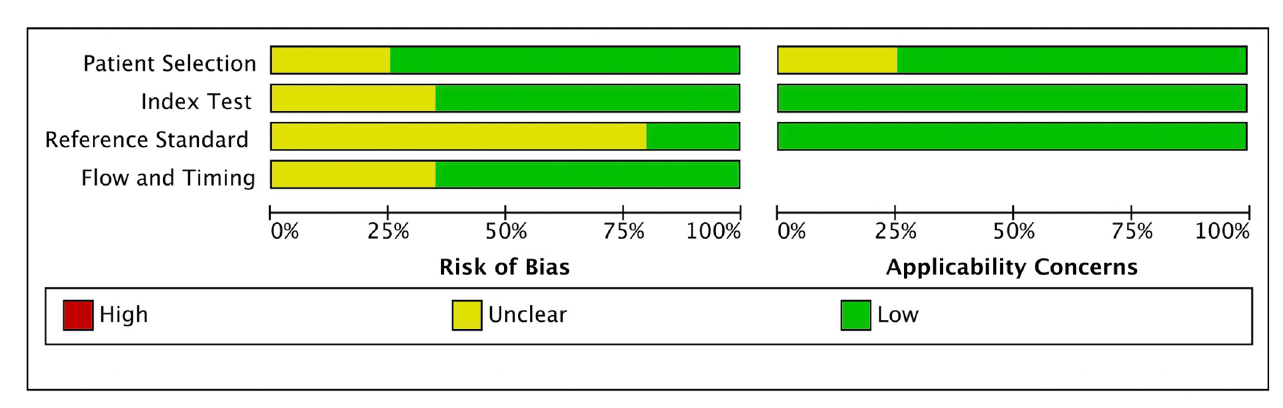
Fig 2. Quality for the included